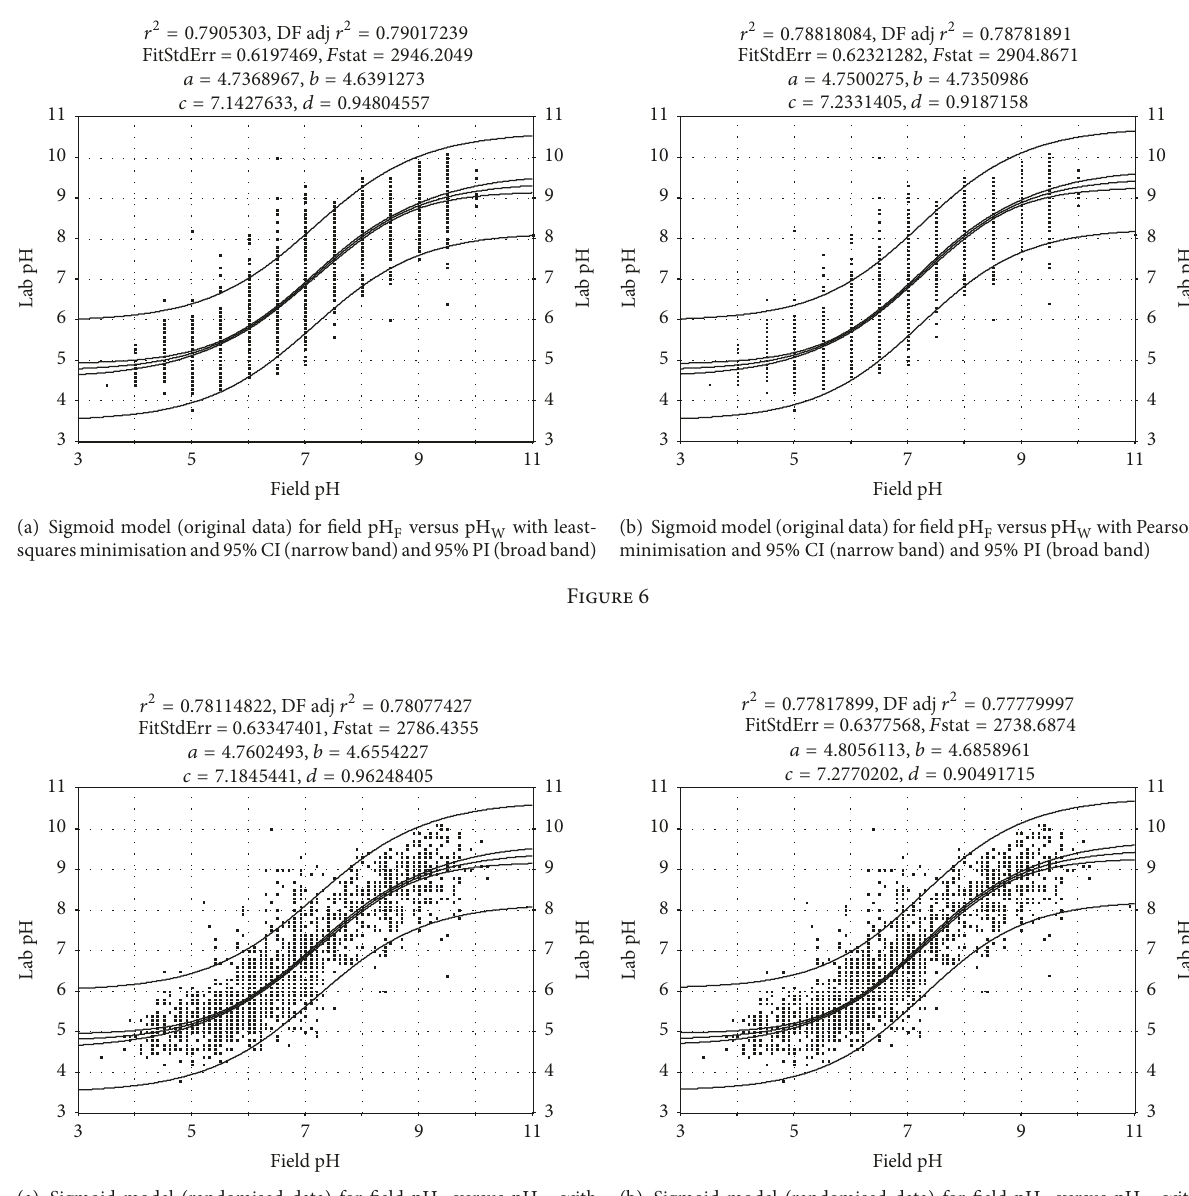
(b) Sigmoid model (randomised data) for field pH F versus pH W with Pearson minimisation and 95 % CI (narrow band) and 95 % PI